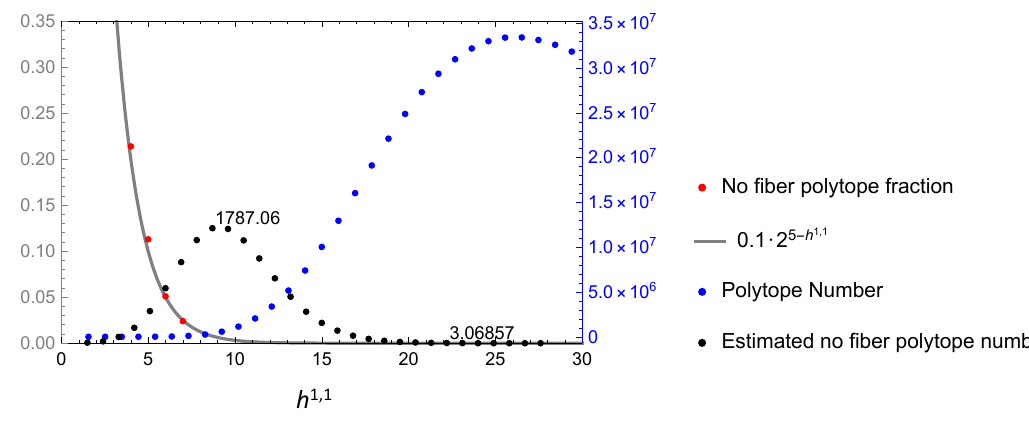
Figure 5 . The fraction of polytopes without a manifest re(cid:13)exive (cid:12)ber goes roughly as 0 : 1 (cid:2) 2 5 (cid:0) h 1 ; 1 for small values of h 1 ; 1 . Continuing this estimate to higher values of h 1 ; 1 , the estimated number of polytopes with no (cid:12)ber has a peak value around 1800 at h 1 ; 1 (cid:24) 9 and drops below (cid:12)ve around h 1 ; 1 (cid:24) 24. The estimated number of total polytopes with no manifest (cid:12)ber is around 14 ; 000. (cid:12)brations continues; this suggests that the tail of the distribution of polytopes lacking